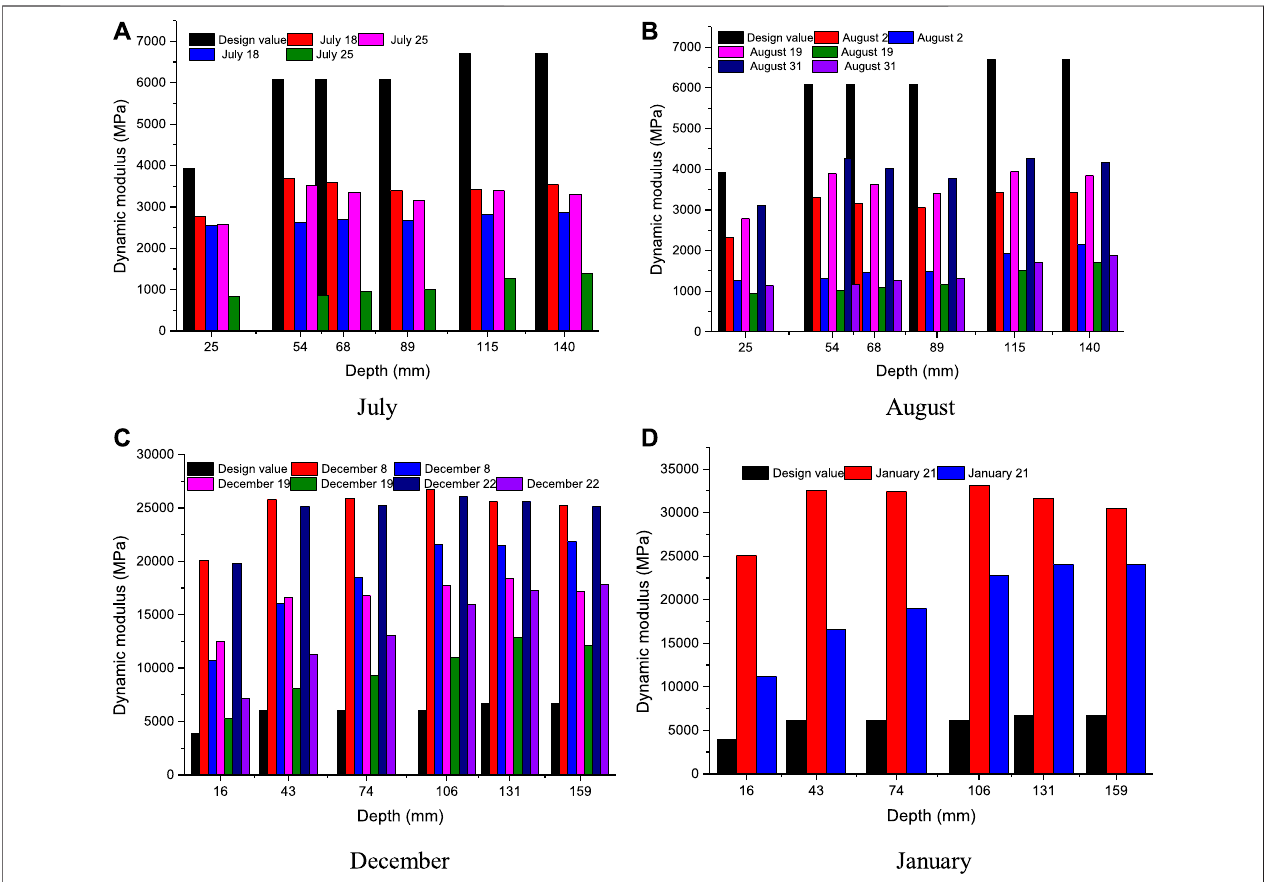
FIGURE 12 | Comparative analysis of dynamic modulus of asphalt pavement.